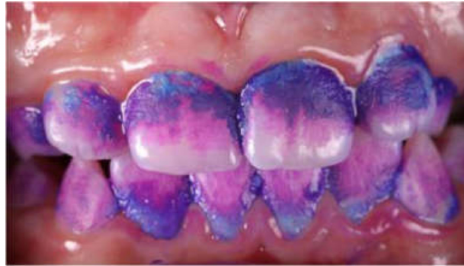
Figure 2. Dental plaque after application of a disclosing